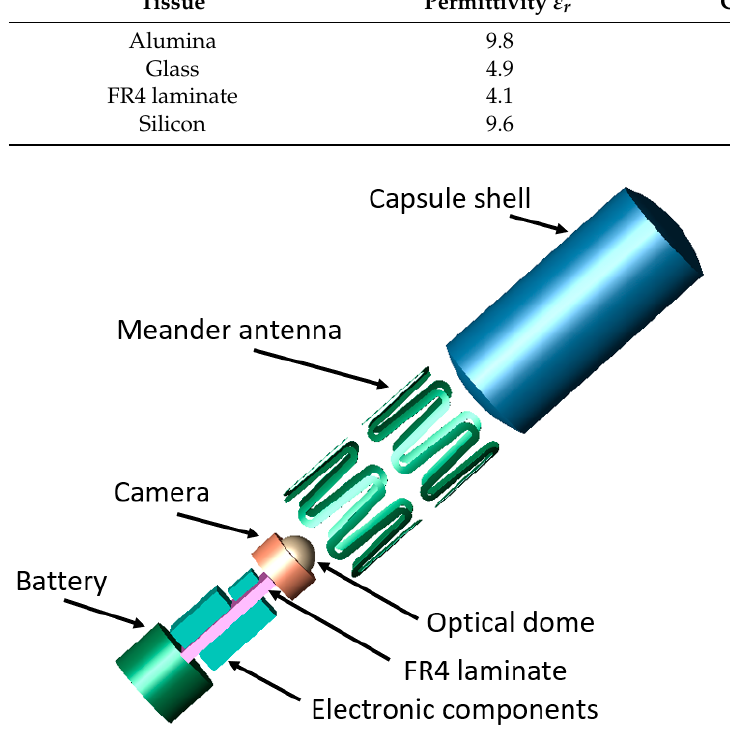
Figure 4. Capsule model used in simulations.